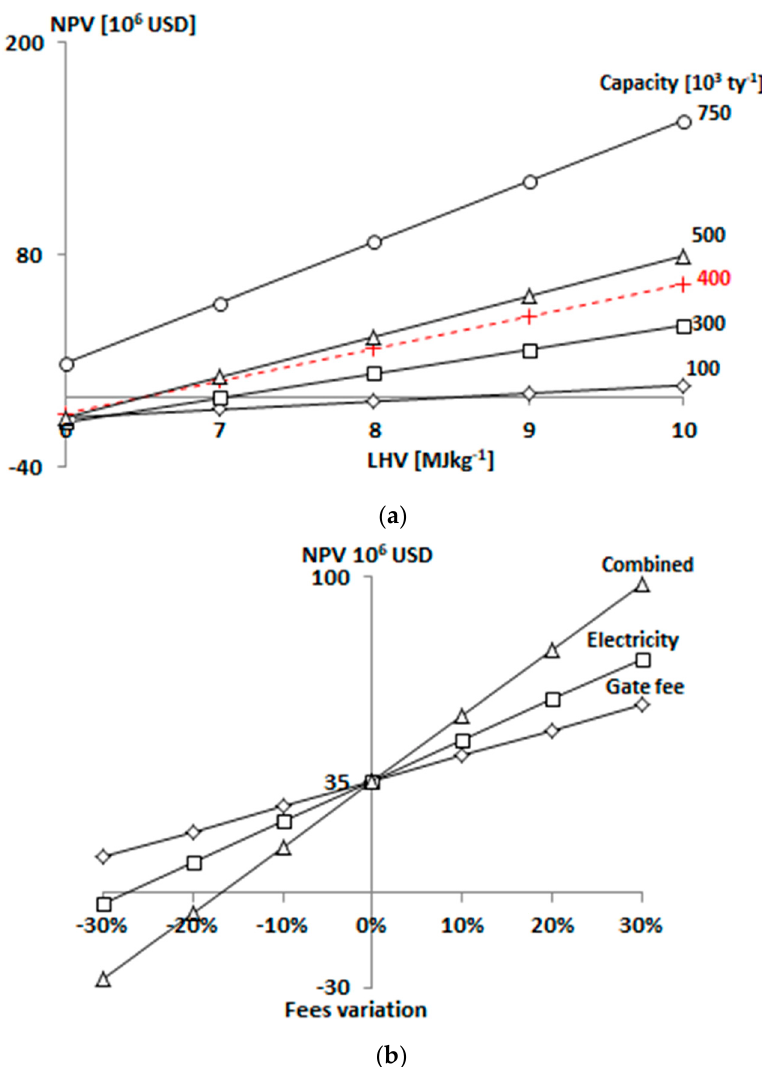
Figure 4. Results from the sensitivity analyses: ( a ) effect of the LHV on the NPV of the project; and ( b ) impact of gate fee and electricity prices variations on the NPV.